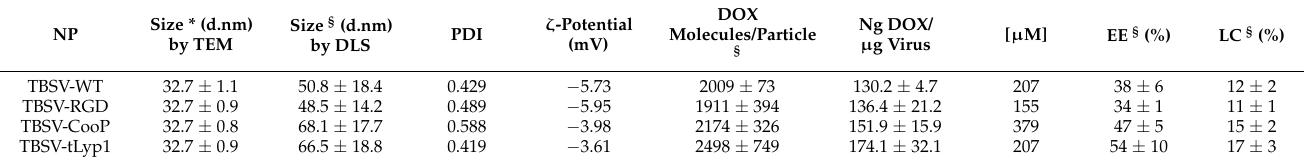
Figure 4. Dynamics and stability of the interaction of CooP-FABP3 and TBSV CPCooP-FABP3. ( A ) Number of clusters as a function of simulation time and their occupancy throughout the trajectory of the CooP-FABP3 complex. ( B ) Simulation snapshots of the CooP-FABP3 complex, taken at selected times of the MD trajectory. The residues of FABP3 involved in the interaction with CooP are represented by licorice model. CooP is colored in green and depicted in licorice model. The representative structures of the most populated clusters and their percentage of occupancy along the trajectory are also indicated. Black dashed lines: hydrogen bonds. ( C ) Structural model of cTBSV in complex with FABP3. Zoom views: simulation snapshot of the asymmetric unit of the cTBSV docked with FABP3 receptor (shown in yellow and by Surface representation model) and simulation snapshots of the CPs of the asymmetric unit docked with FABP3 (shown by New Cartoon representation model) taken at selected times of the MD trajectory. The CooP peptide is depicted in licorice model and colored in green. Table 1. Characterization of TBSV nanoparticles in DLS/ ζ -potential evaluation and DOX